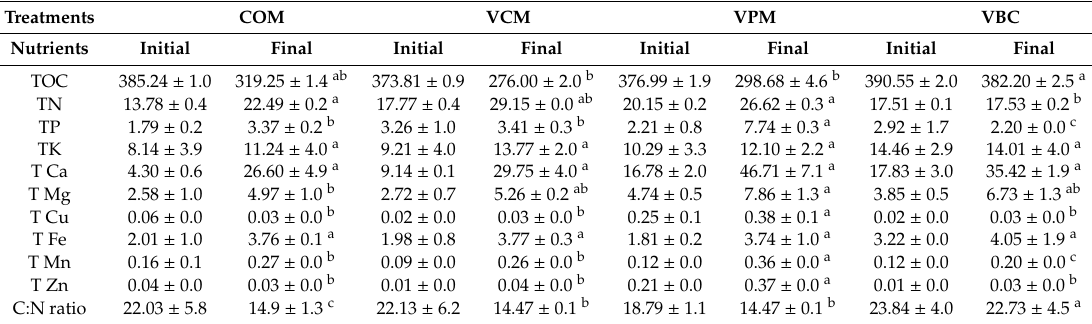
Table 1. Initial and final nutrient contents (g kg − 1 ) within treatments.